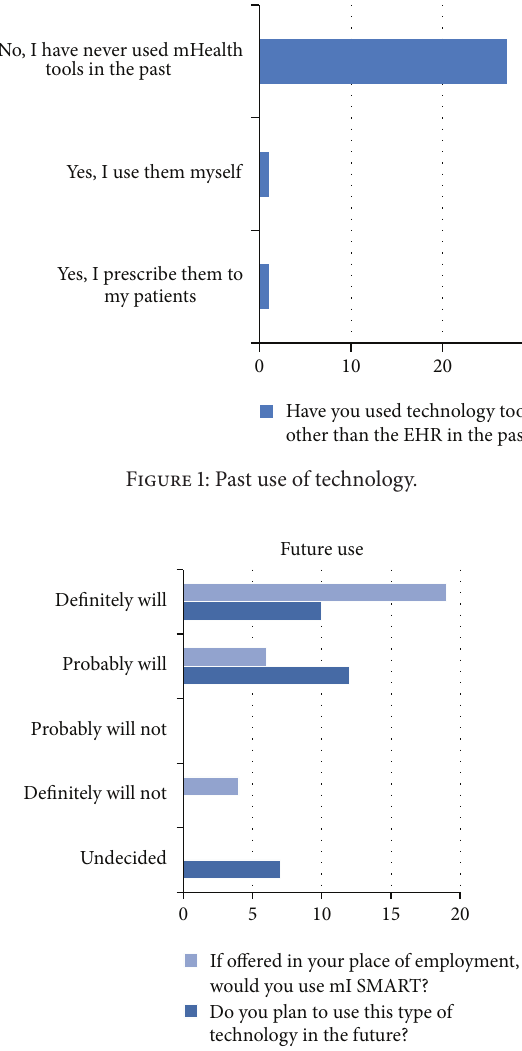
Figure 2: Future use of mI SMART and other